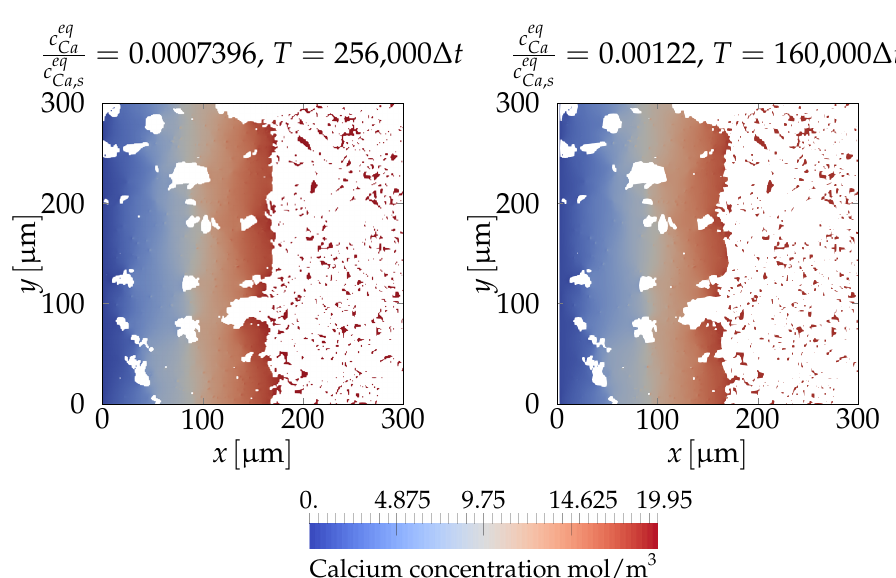
Figure 9. Slices at z = 150 µ m in the calcium concentration field for: the simulation where the original value of the ratio between the saturation concentration in the pore solution and the hydrated solid c eq = 0.00122 where the acceleration approach by [63] is used ( right ). In the first case, we used and the simulation of c eq / c eq Ca Ca , s 256,000 time steps, while in the second case, only 160,000 time steps were used to obtain the